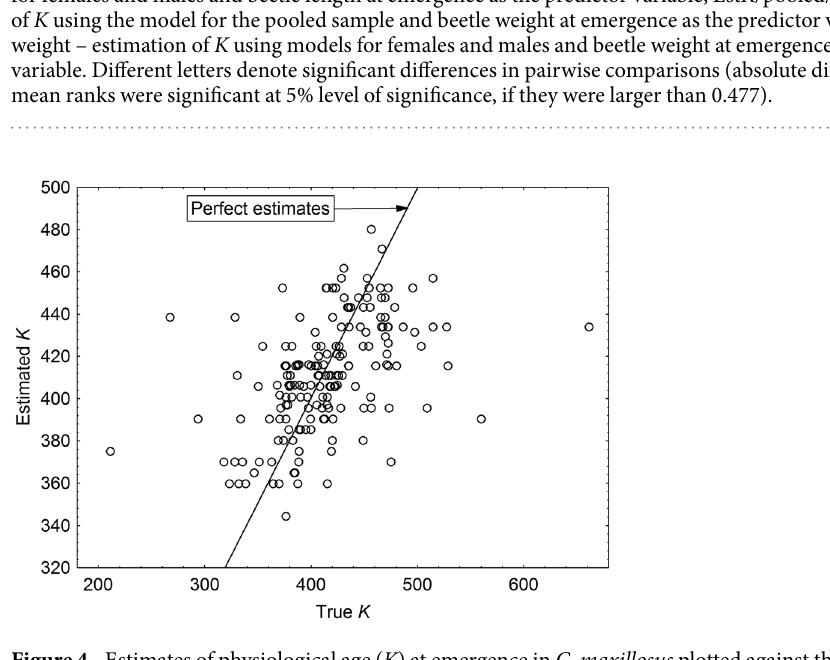
Figure 4. Estimates of physiological age ( K ) at emergence in C. maxillosus plotted against the true age. K was estimated using sex-specific models regressing K and beetle length at emergence. Solid line – hypothetical line representing perfect